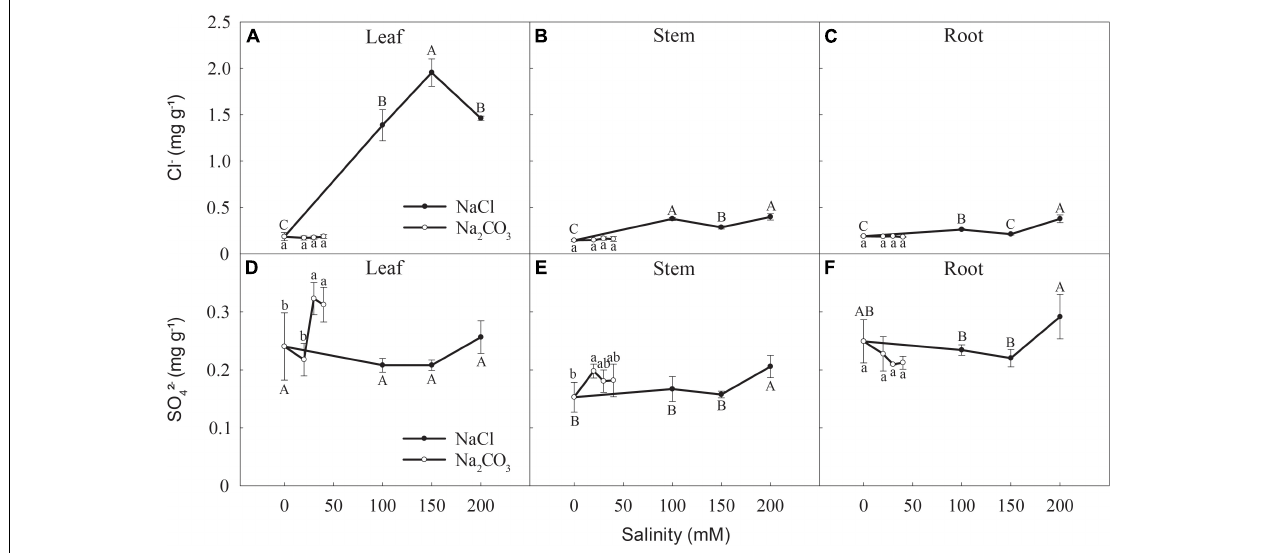
FIGURE 6 | Changes in the concentrations of (A–C) Cl − and (D–F) SO 42 − in the leaves, stems, and roots of canola seedlings after 7 days of NaCl and Na 2 CO 3 stress. Different uppercase and lowercase letters indicate significant difference among NaCl and Na 2 CO 3 concentrations, respectively, according to a least significant difference (LSD) test ( P <